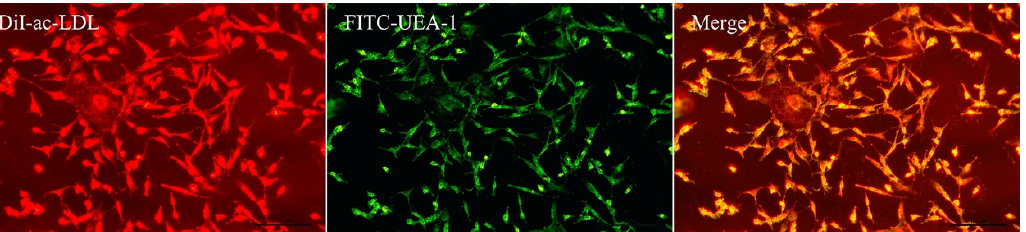
Figure 1. Characterization of endothelial progenitor cells (EPCs). Fluorescent analyses to determine the Dil ‐ ac ‐ LDL uptake and FITC ‐ UEA ‐ 1 ‐ binding capability of EPCs. Bar, 100 μ m. 3.2. Effect of 8 ‐ Week Aerobic Exercise on the Senescence, Proliferation, and Migration of EPCs in